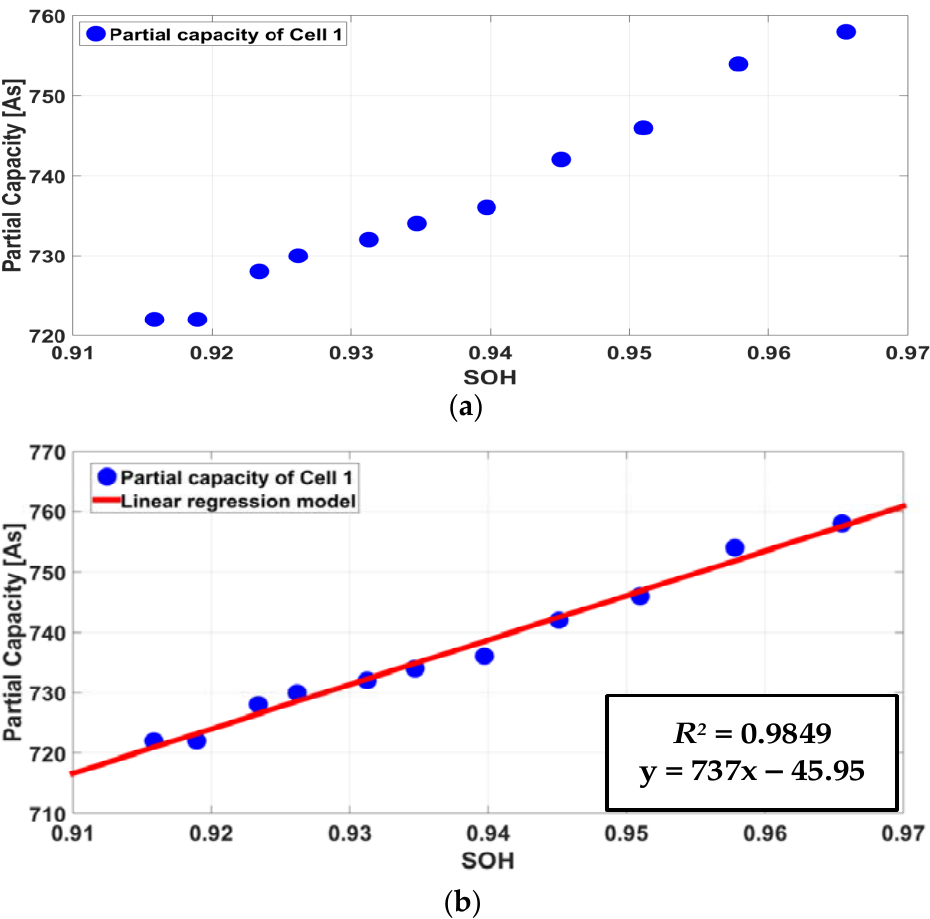
Figure 14. Variation in the partial capacity with respect to the SOH according to the IC curve valley point 1 in the short voltage range (3.6–3.7 V) (no. 1 cell): ( a ) experimental IC curve valley point 1, and ( b ) comparison between the linear regression model and experimental IC curve valley point 1 (R 2 = 0.9849).